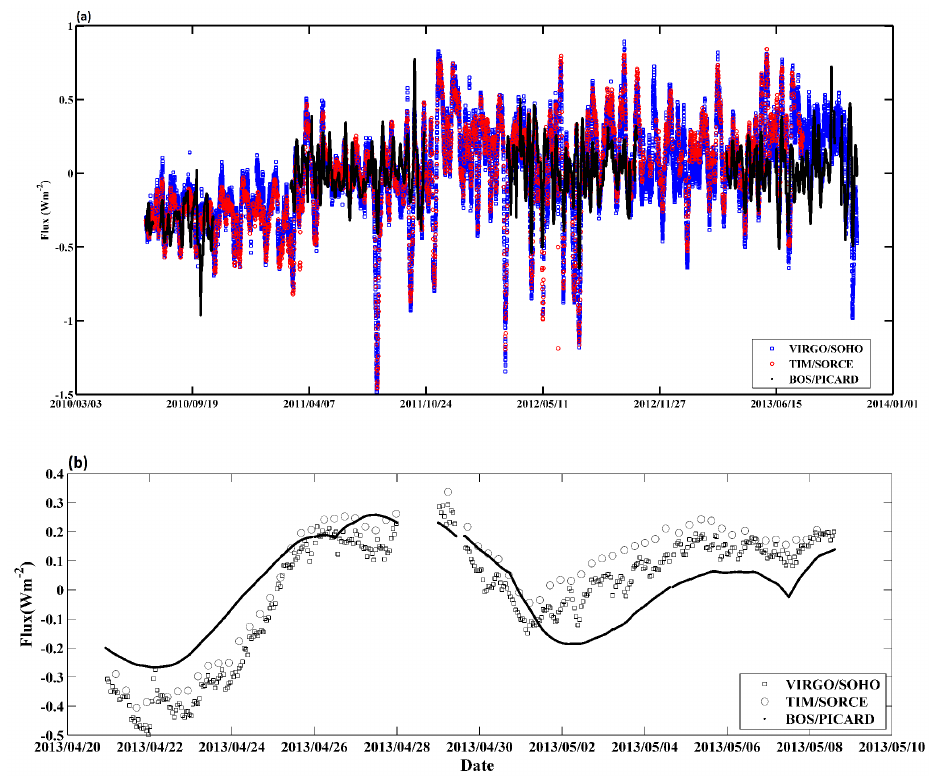
Figure 8. Comparison of the BOS with VIRGO/SOHO and TIM/SORCE. The upper panel shows the records during the whole PICARD lifetime. The cross-correlations are BOS-VIRGO 60 . 3%, BOS-TIM 61 . 7%, and VIRGO-TIM 97 . 5%. The lower panel shows a zoom-in of the upper panel; the three measurements are plotted together with the sampling periods of 10s for the BOS, 1h for VIRGO and 6h for TIM. The cross-correlation coefficients over this period are BOS-VIRGO 66 . 5%, BOS-TIM 62 . 3%, and VIRGO-TIM 90 .